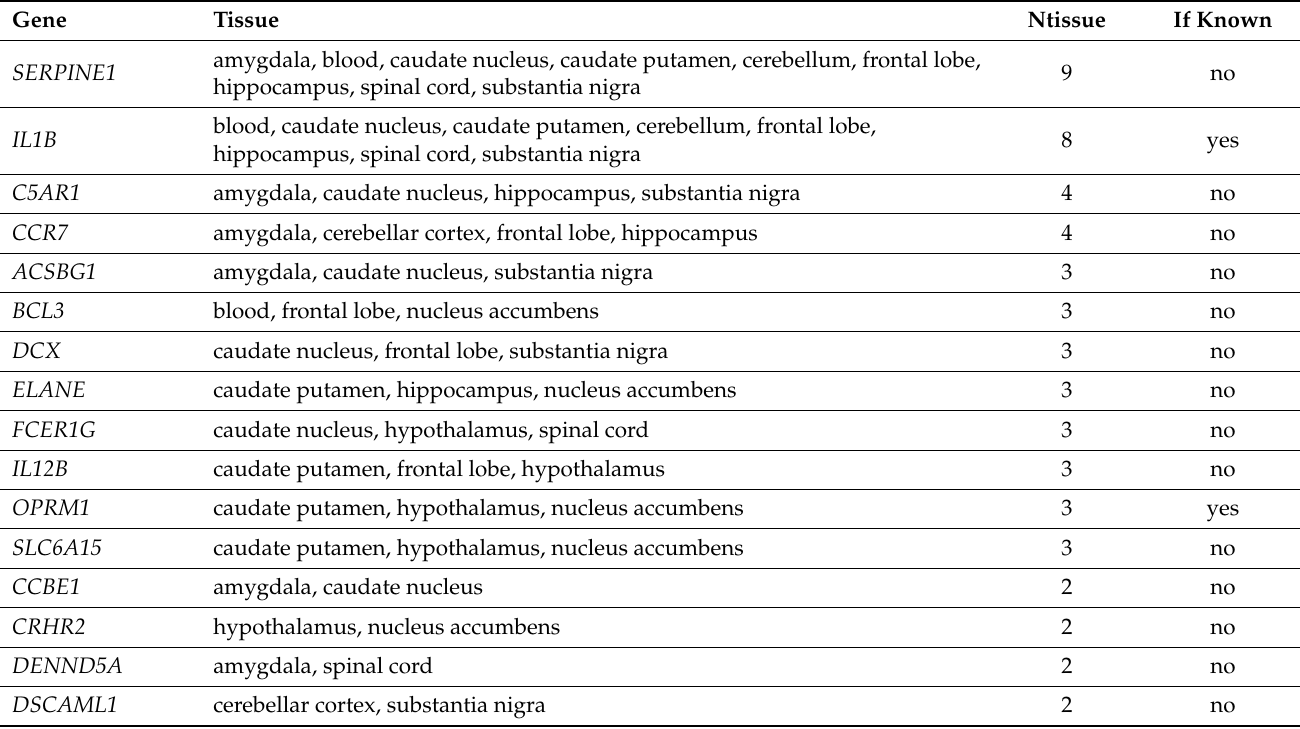
Table 1. Conservative KDs identified in NP and